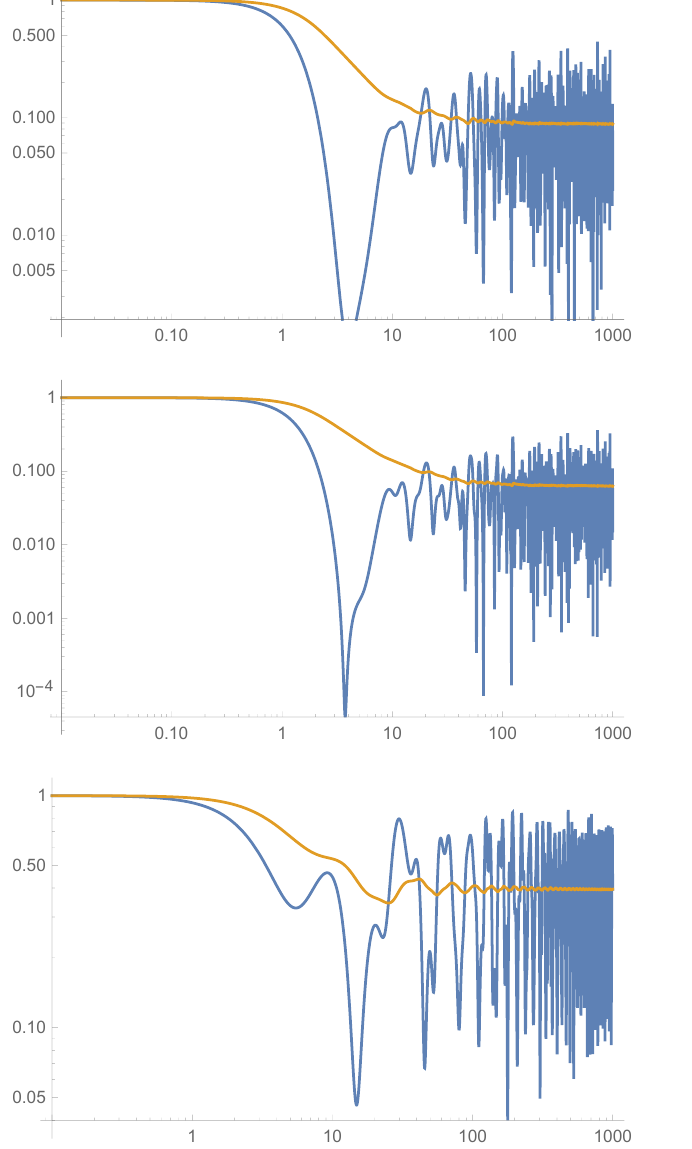
Figure 2 . The progressive time average (3.4) for the GW model. Top: (cid:12) = 0 : 1, center: (cid:12) = 1, bottom: (cid:12) =